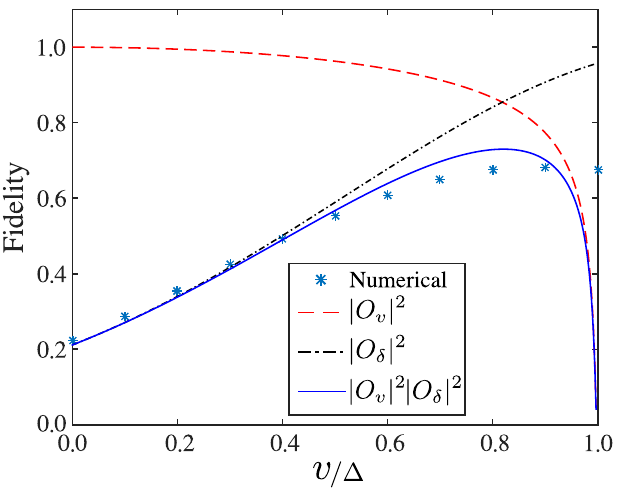
FIG. 5. Contours showing the infidelity I for the bare (one- wall) jump-move-jump strategy [Eq. (10)] as a function of dis- tance l and time T using the same fitted parameters as Fig. 4. The red dashed line indicates when v avg = l / T = v crit , which can be used to distinguish the different Majorana motion regimes as defined in Fig. 1 (c). The jump-move-jump protocol allows for low infidelities even in cases where the average velocity exceeds v crit [regime